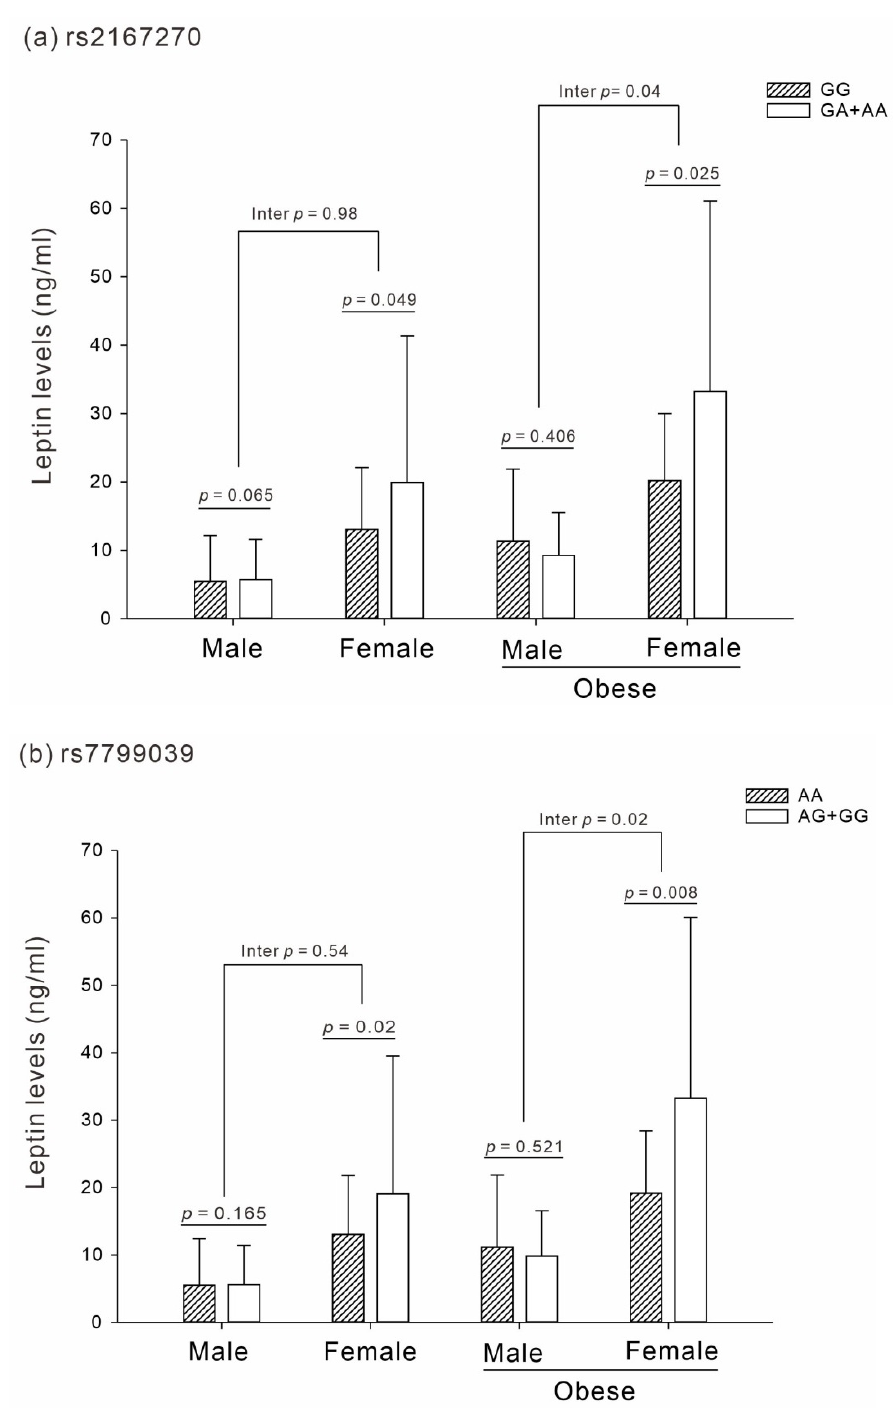
Figure 1. Association and interaction analysis between LEP SNPs and leptin levels in sex according to obesity status ( p adjusted for age and smoking status). ( a ) Interaction effect of rs2167270 ( p = 0.04). ( b ) Interaction effect of rs7799039 ( p =